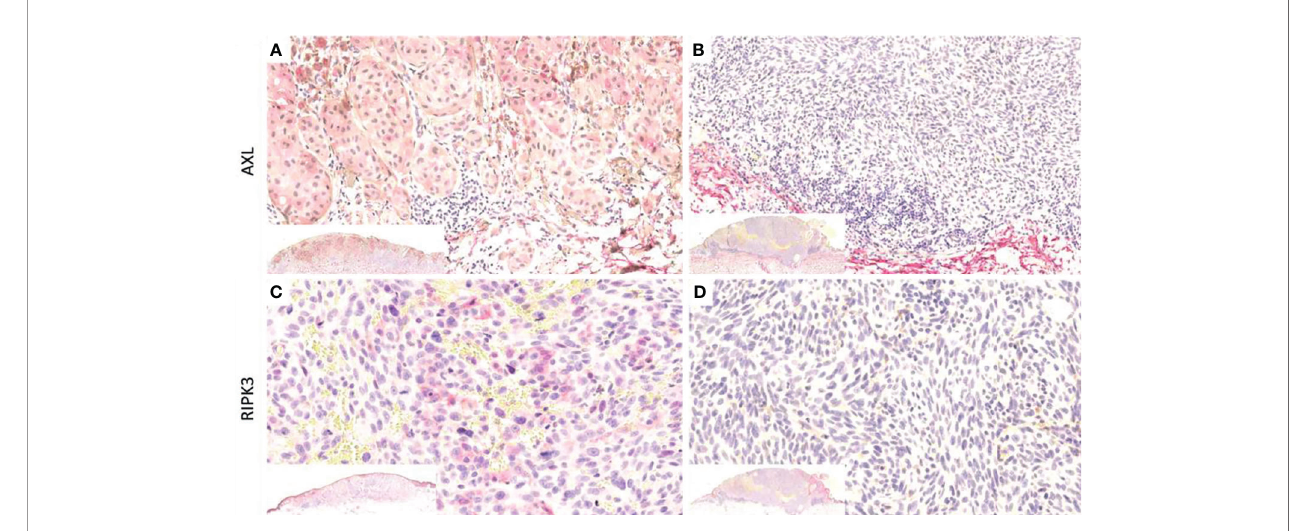
FIGURE 1 | Representative cases showing immunoreaction for AXL (A) and RIPK3 (C) immunostain, and cases with no immunoreaction for AXL (B) and RIPK3 (D) immunostain. In the inner box on the low left of each picture, the correspondent case is shown. (B, C) Some case. Original magni fi cation,